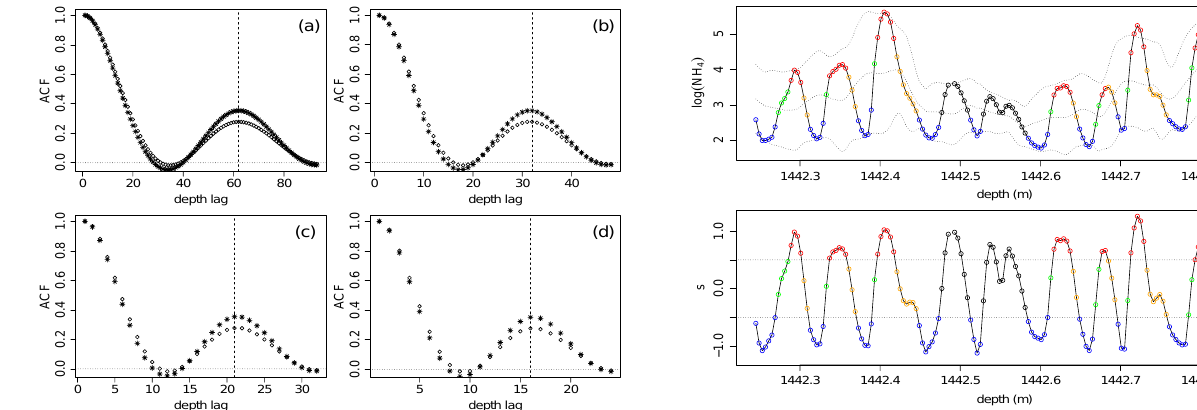
Fig. 8. The ACFs of the log NH4 (circles) and log Ca (stars) signals from the NGRIP ice-core (1440.49–1464.81m), plotted against lag. The vertical dashed lines indicate the local maxima, used to obtain an initial estimate of cycle length. (a) No thinning. (b) Second thin- ning. (c) Third thinning. (d) Fourth thinning.